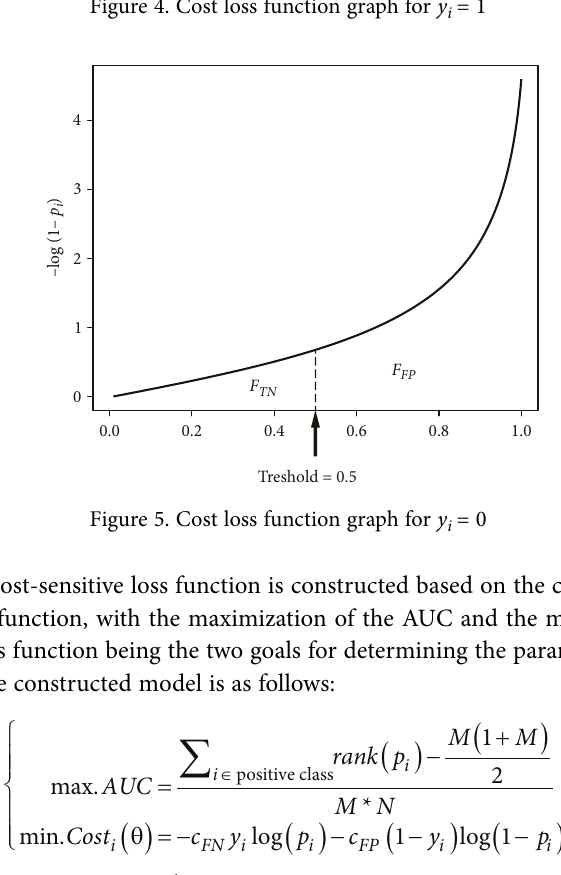
Figure 4. Cost loss function graph for y i = 1